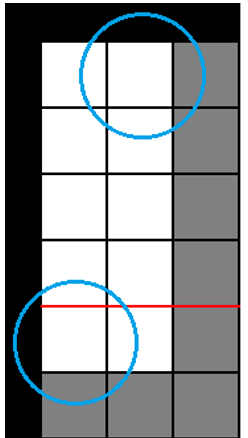
Figure 14. Bubble-compliant office block with outdoor connection.